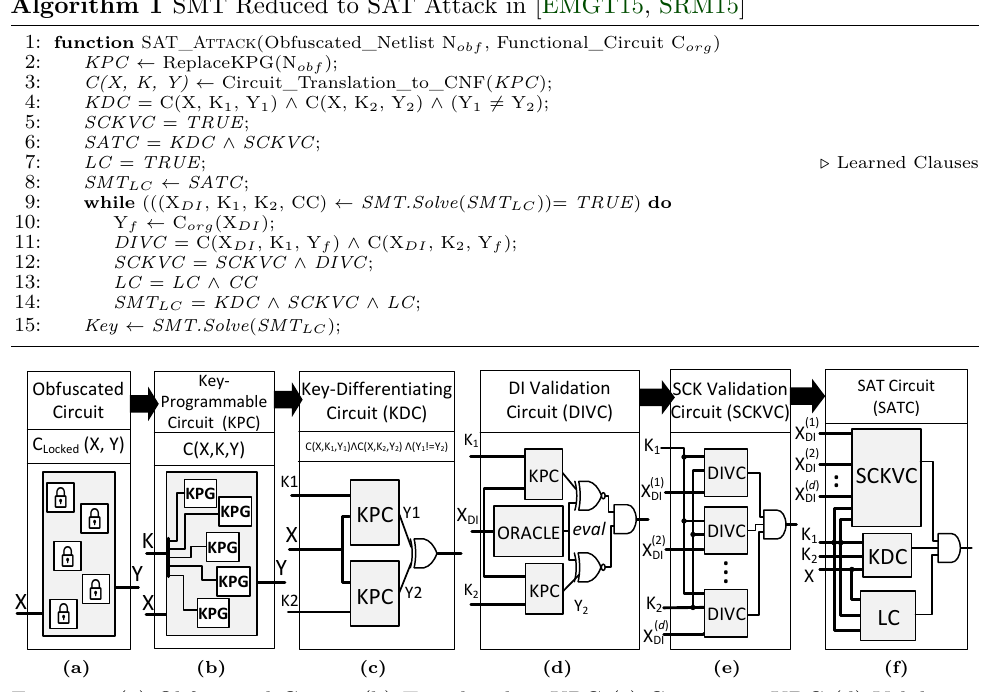
Figure 6: (a) Obfuscated Circuit (b) Translated to KPC (c) Generating KDC (d) Validation Circuit for Discriminating Inputs (DIVC) (e) Generating SKCVC (f) constructing The final Satisfiability Circuit (SATC) for finding a new